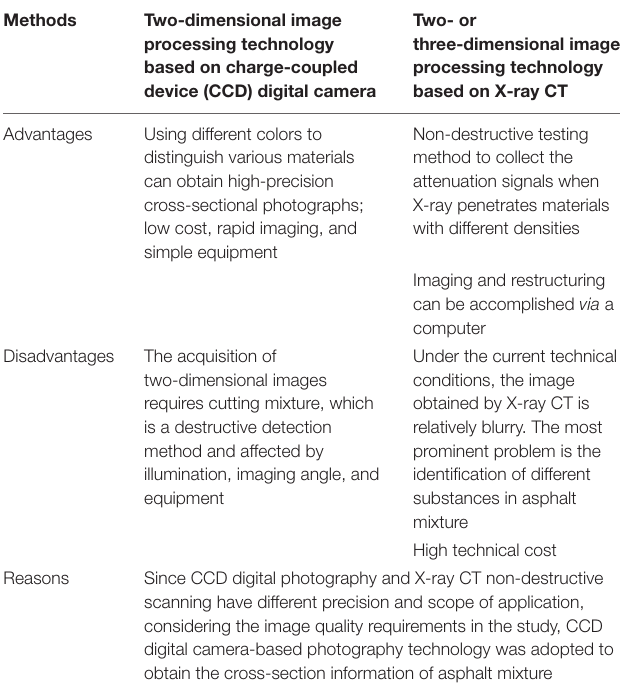
TABLE 4 | Comparison between image processing technology.